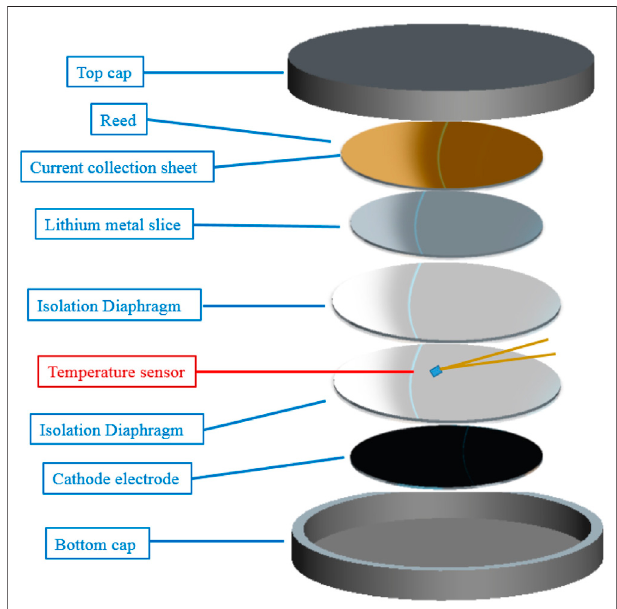
FIGURE 3 | A Pt-1000 RTD sensor in a coin cell (Wang et al., 2016, Panel 4, p. 462). Reprinted from (Wang et al., 2016), Copyright (2016) with permission from